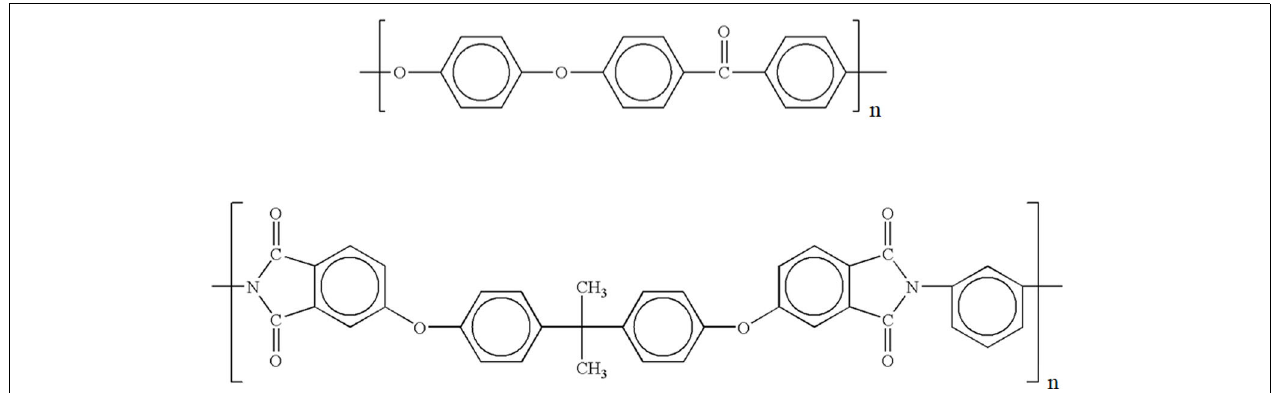
FIGURE 1 | Repeating units of PEEK (top) and PEI